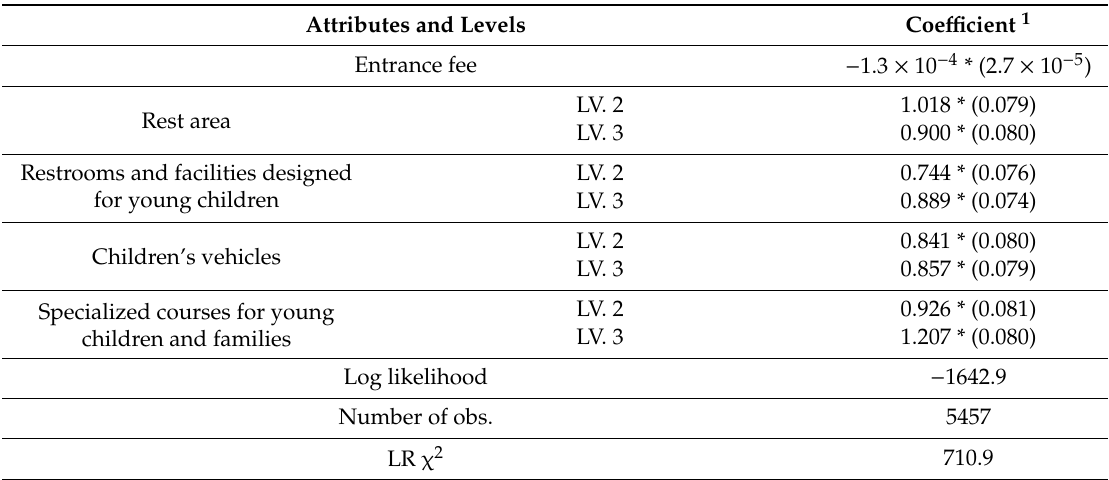
Table 3. Conditional logit model estimation results for child-friendly facilities and services.